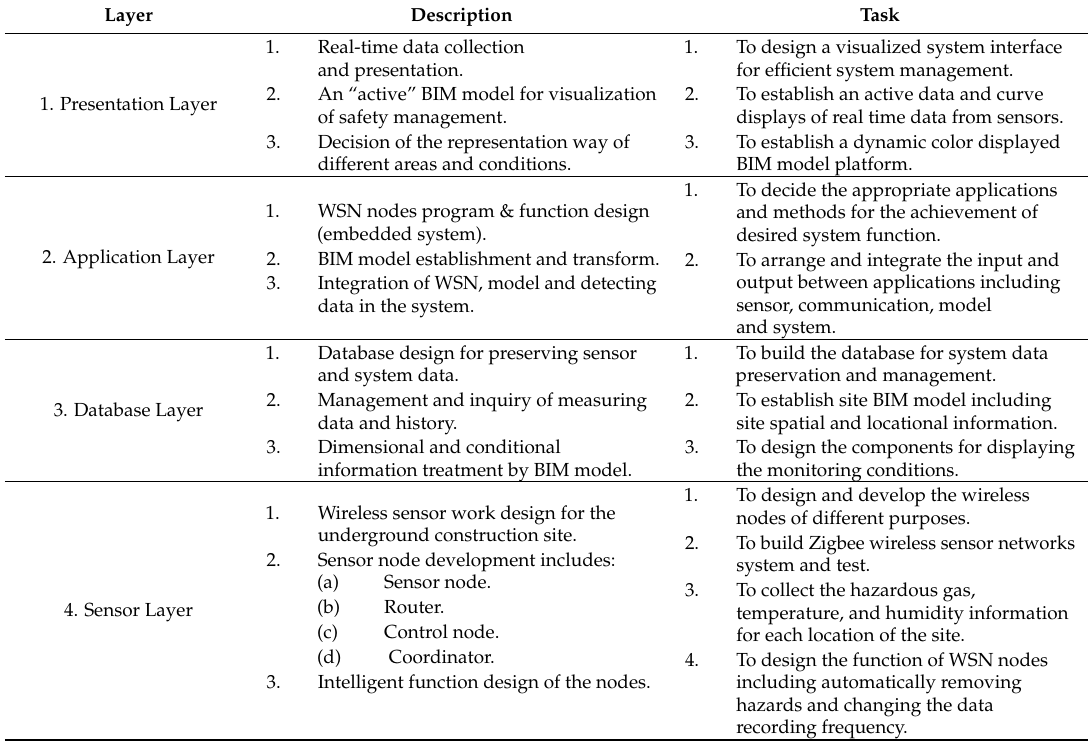
Table 1. The description and task of designed